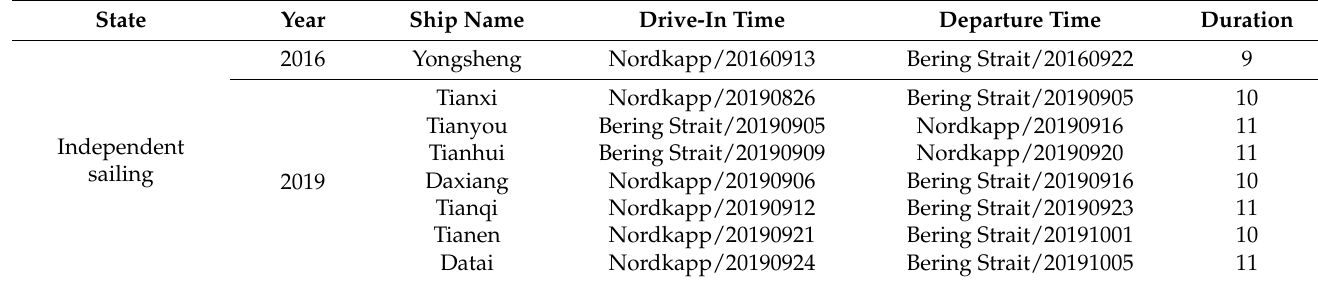
Table 2. Summary of cargo ship sailing